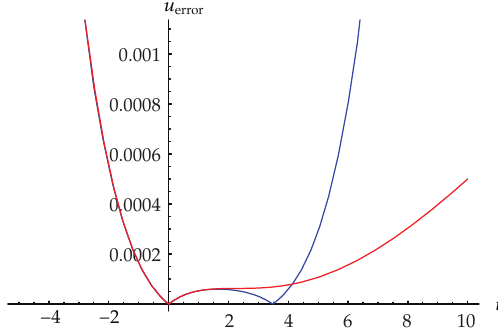
Figure 2: The error curves for the GDTM solutions (cid:4) blue (cid:5) and the GDTM-Pad´e solutions (cid:4) red (cid:5)